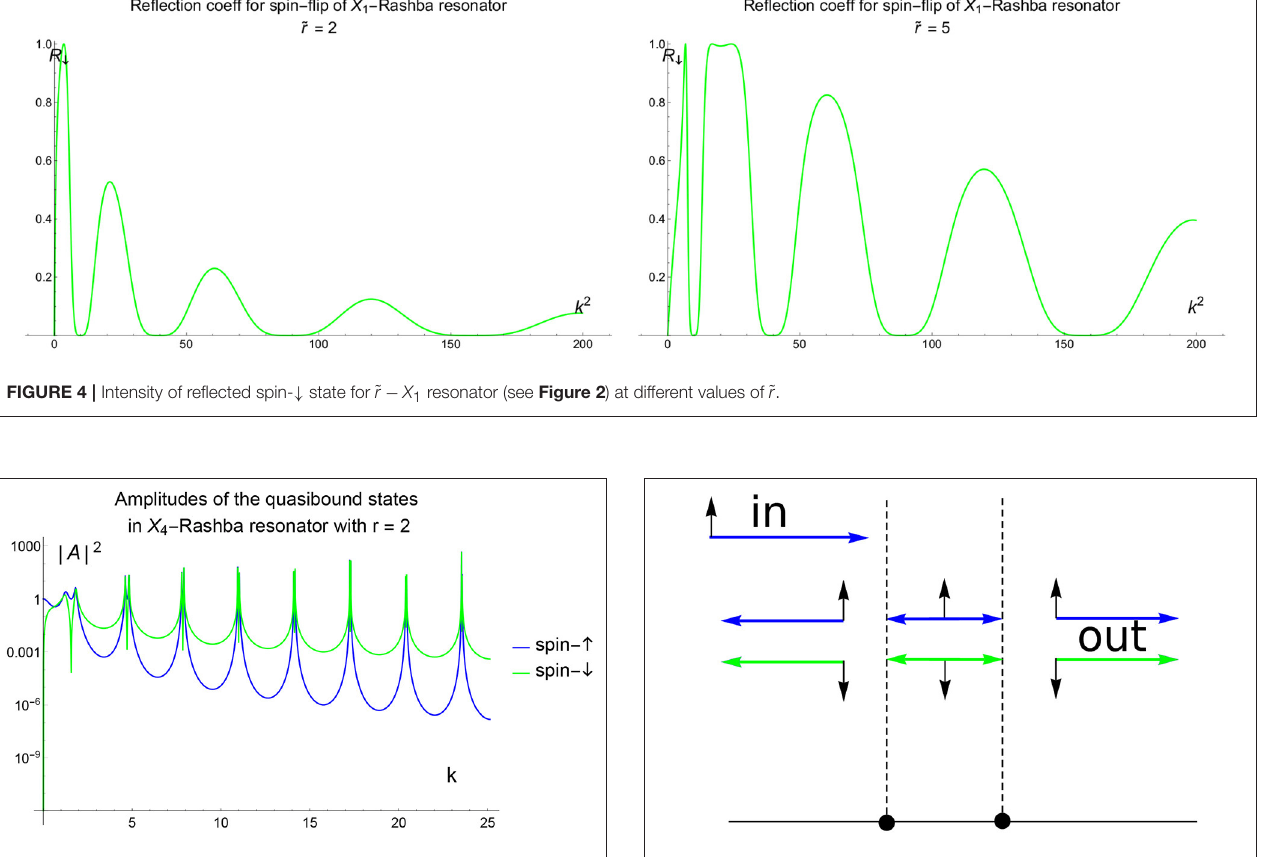
, -components in the |↑i |↓i